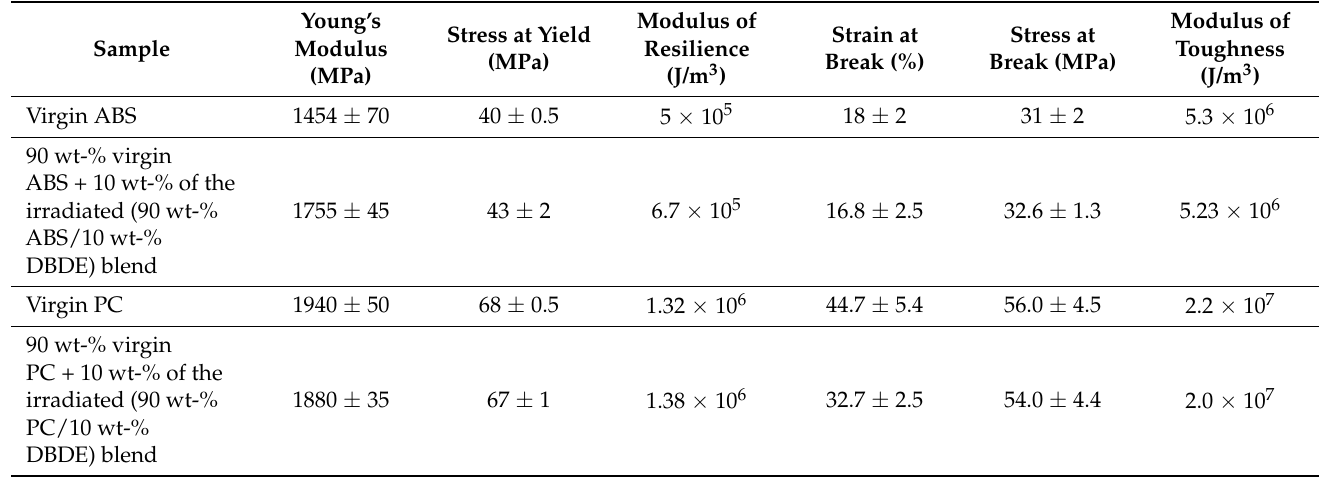
Figure 8. Stress-strain behavior of virgin ABS and PC and samples composed of 90 wt-% virgin ABS + 10 wt-% of the irradiated blend (90 wt-% ABS/10 wt-% DBDE), and 90 wt-% virgin PC + 10 wt-% of the irradiated blend (90 wt-% PC/10 wt-% DBDE). Table 1. Summary of tensile properties of virgin ABS and PC, and samples composed of 90 wt-% virgin ABS + 10 wt-% of the irradiated blend (90 wt-% ABS/10 wt-% DBDE), and 90 wt-%